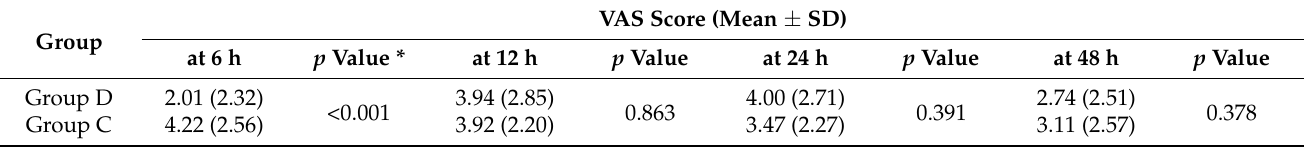
Table 2. Comparison of VAS scores at each time point between the